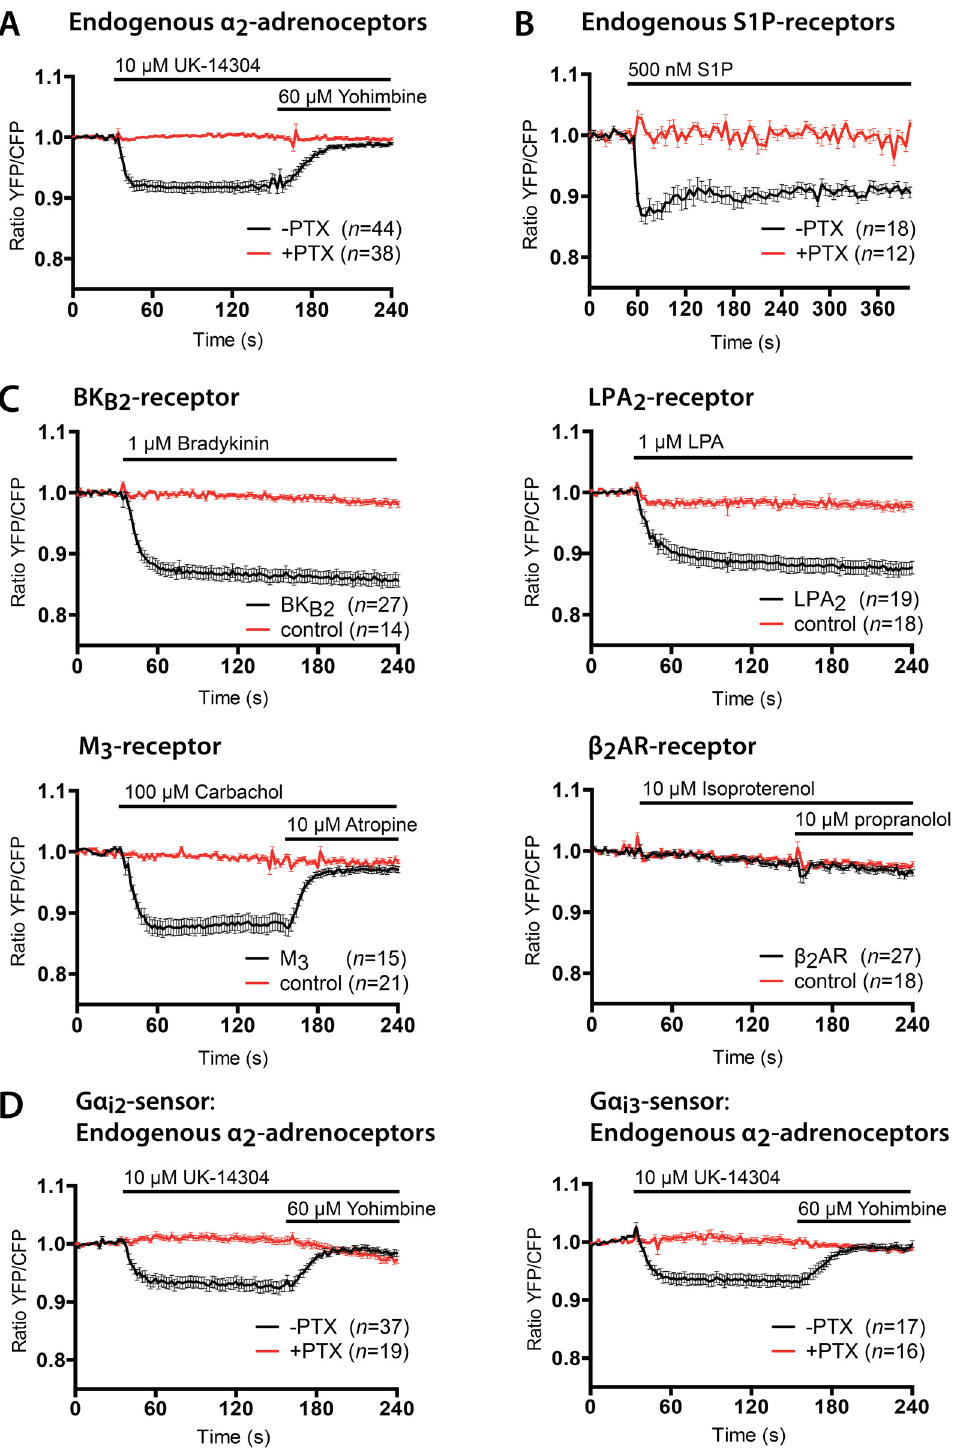
Fig 2. Performance of the G α i -sensors in single cell GPCR signaling assays. (A) FRET ratio-imaging experiments in HeLa cells transfected with the G α i1 -sensor. Rapid loss of FRET, observed by a decreased YFP/CFP ratio, after stimulation of the cells with 10 μ M UK-14,304, an α 2 AR specific agonist, addition of 60 μ M Yohimbine returns the FRET ratio towards baseline levels. Overnight treatment with (100ng/mL) PTX abolishes the response on the G α i1 - sensor in UK-14304 stimulated cells. (B) FRET ratio-imaging experiments in Huvecs transfected with the G α i1 -sensor. A sustained loss of FRET is observed after stimulation with 500nM S1P (Sphingosine-1-phosphate). Overnight treatment with (100ng/mL) PTX abolishes the response on the G α i1 -sensor in S1P